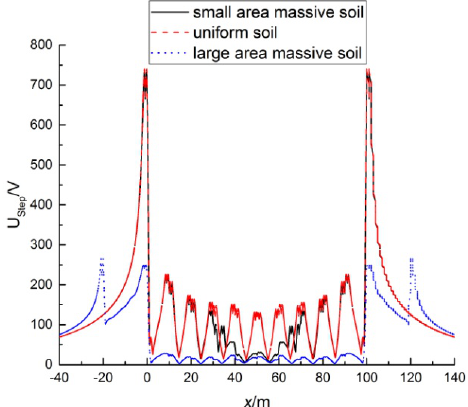
Figure 2. Step voltage with different backfill material areas.